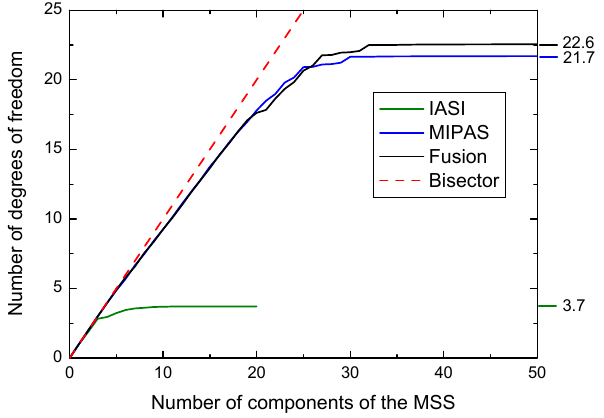
Fig. 8. Ozone VMR profile (a) derived from the data fusion of real IASI and MIPAS measurements and its characterization by means of the percentage retrieval errors (b) and of the AKs relative to 5km step altitudes (c) .